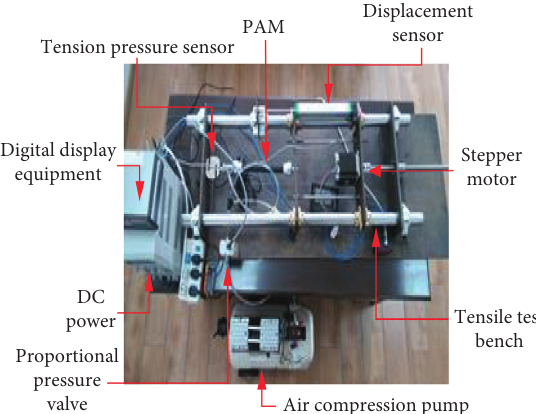
Figure 6: The physical diagram of